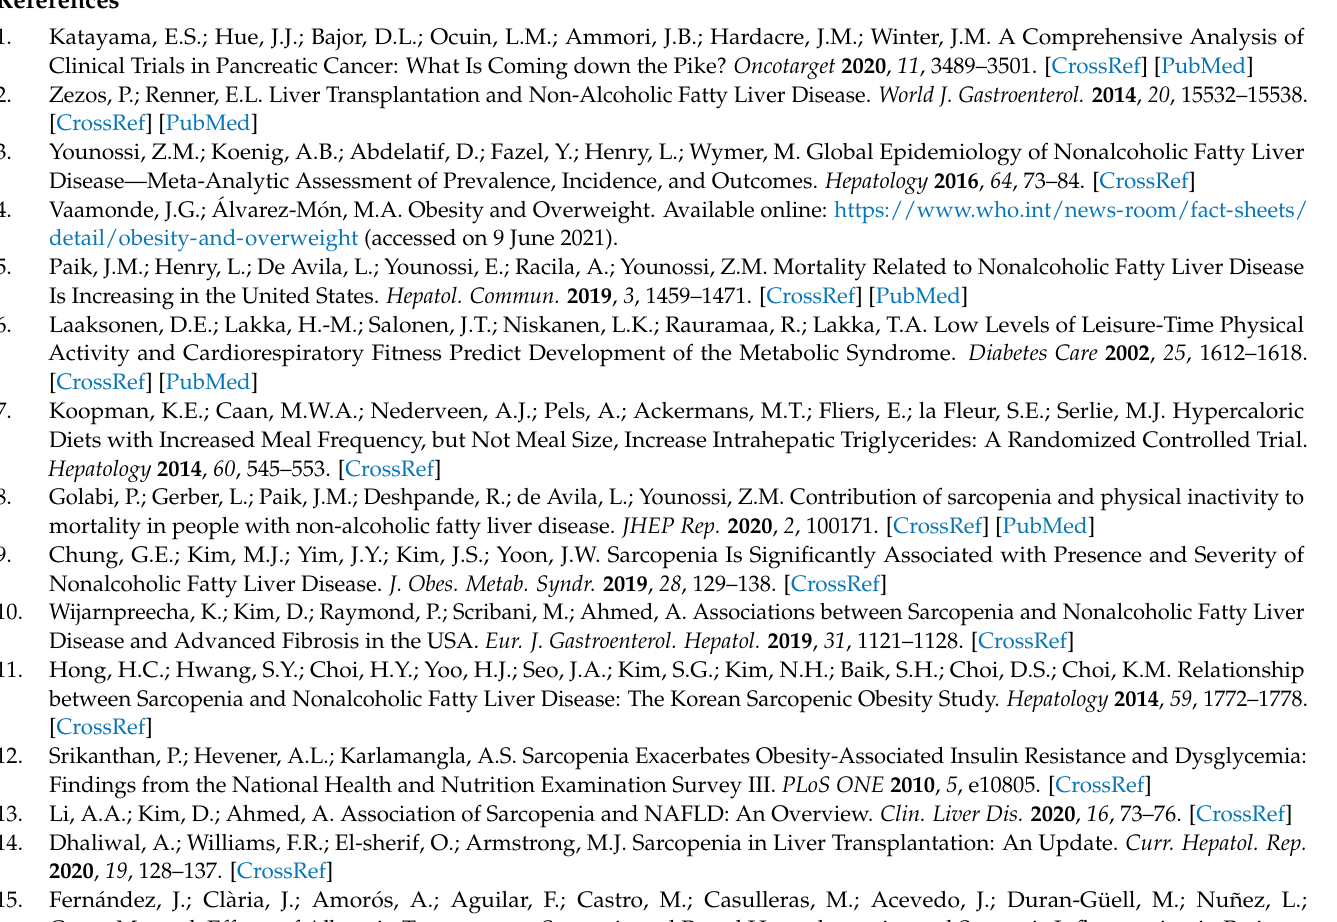
cytochemistry; Table S2: List of secondary antibodies for immunocytochemistry; Table S3: List of fluorescent stains for fluorescence staining; Table S4: Primer sequences for gene expression